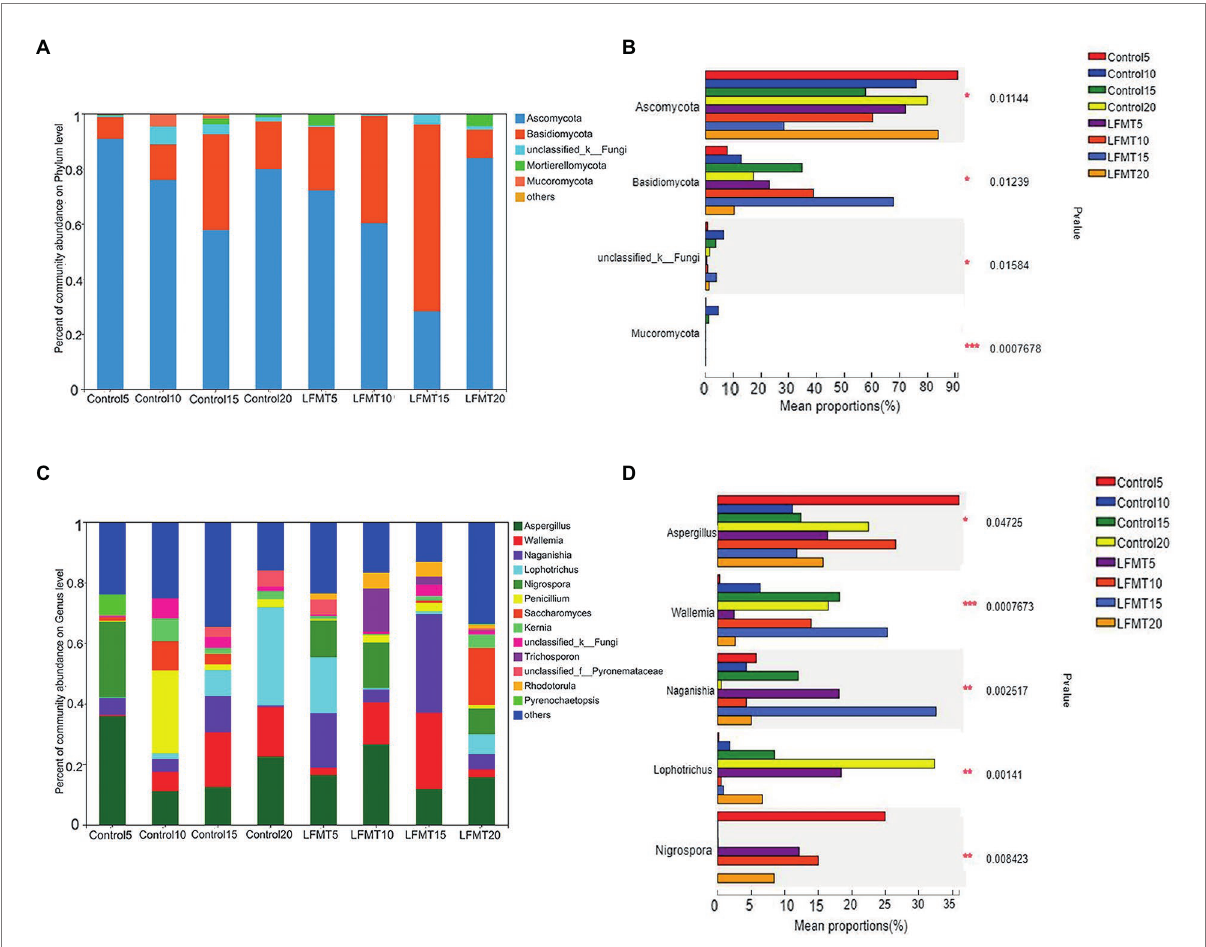
FIGURE 5 Comparison of fecal fungal microbiota composition of Holstein dairy calves in the LFMT and Control groups at four time points after weaning. (A) Relative abundance of fungal microbiota composition at the phylum level. (B) Significantly different phyla were identified using the Kruskal– Wallis H -test. (C) Relative abundance of fungal microbiota composition at the genus level. (D) Significantly different genera were identified using the Kruskal–Wallis H -test. * p < 0.05, ** p < 0.01 and *** p ≤